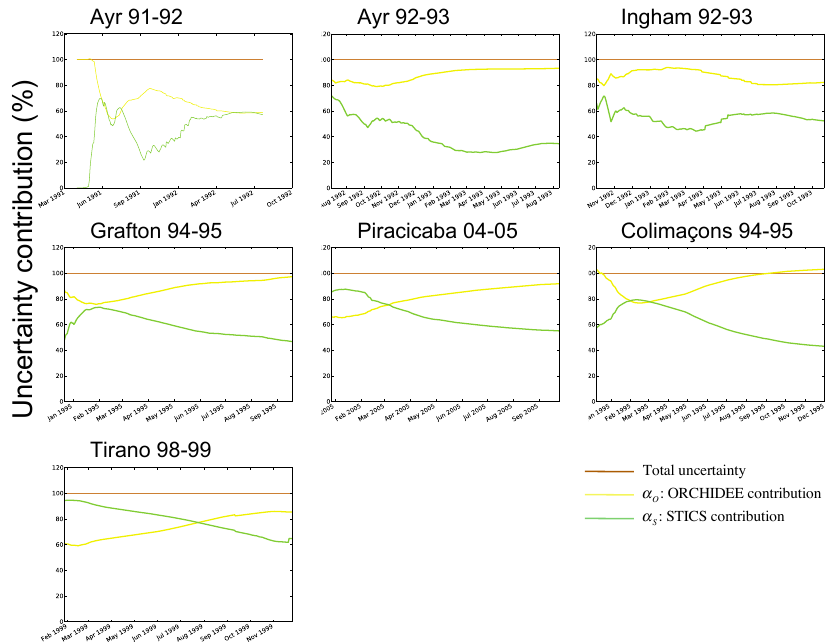
Figure 7. Contribution (%) of ORCHIDEE (yellow) and STICS (green) to the total uncertainty (brown) over the length of the growing season for seven